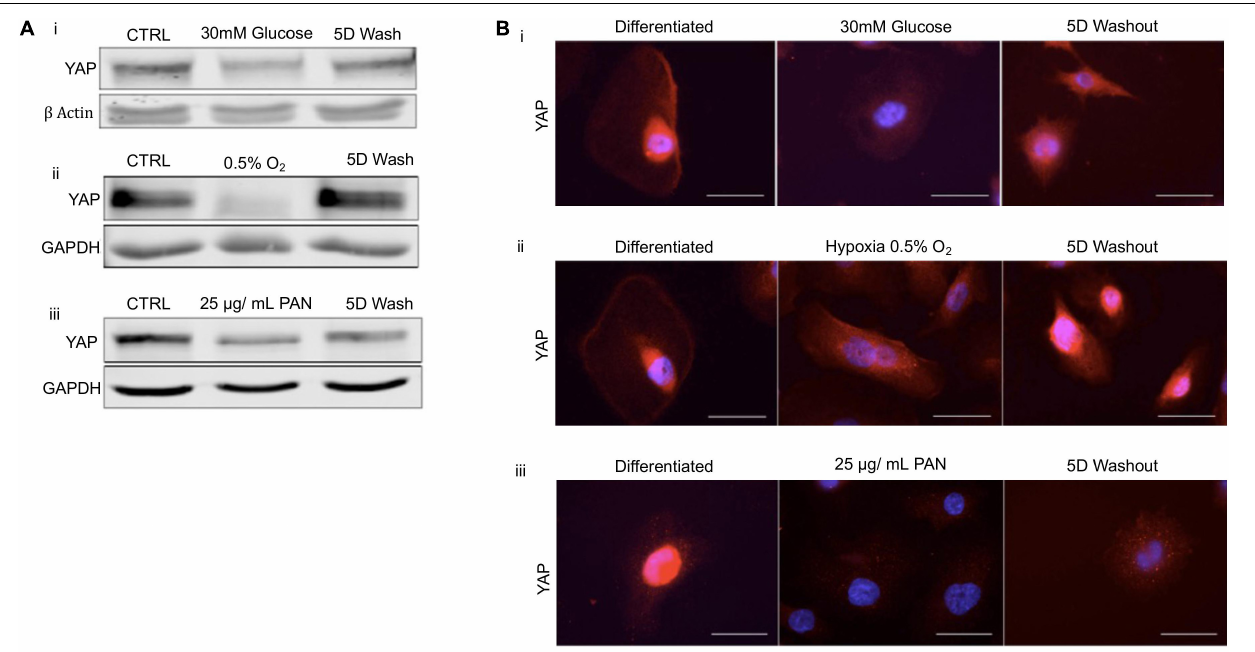
FIGURE 4 | Podocyte stress response induces reversible cytoplasmic translocation of YAP in vitro (A) Western blots for YAP comparing differentiated control podocytes, injured podocytes (i) 30 mM glucose, (ii) hypoxia (0.5% O 2 ), (iii) 25 µ g/mL PAN, and 5 day washout of injury condition or return to normoxia. β -Actin and GAPDH were used as loading controls. (B) Representative immunofluorescence images of YAP expression (red) in podocytes treated with (i) 30mM glucose, (ii) hypoxia (0.5% O 2 ), and (iii) 25 µ g/mL PAN compared to differentiated control and 5 day washout of injury condition. DAPI (blue) detects nuclei. Magnification, 40 × . Scale bar = 50 µ